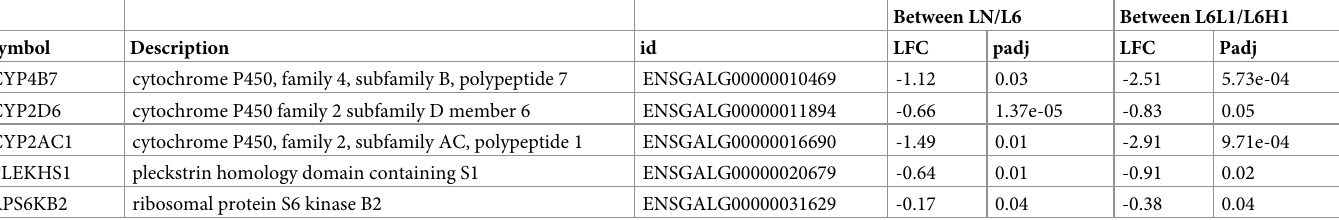
Table 2. Common differentially expressed genes upregulated between LN/L6 analysis and L6L1/L6H1 analysis (potentially associated with susceptibility to Salmonella